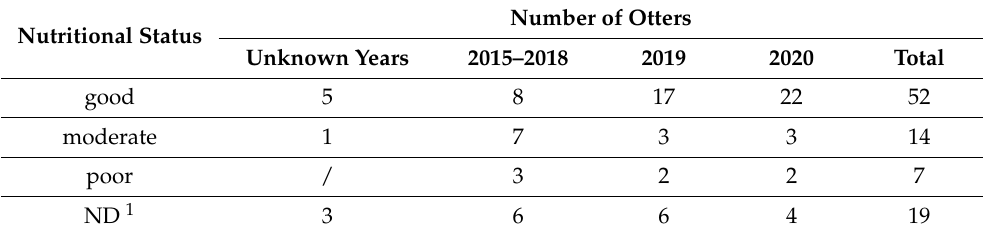
Table 2. Nutritional status of otters found dead in